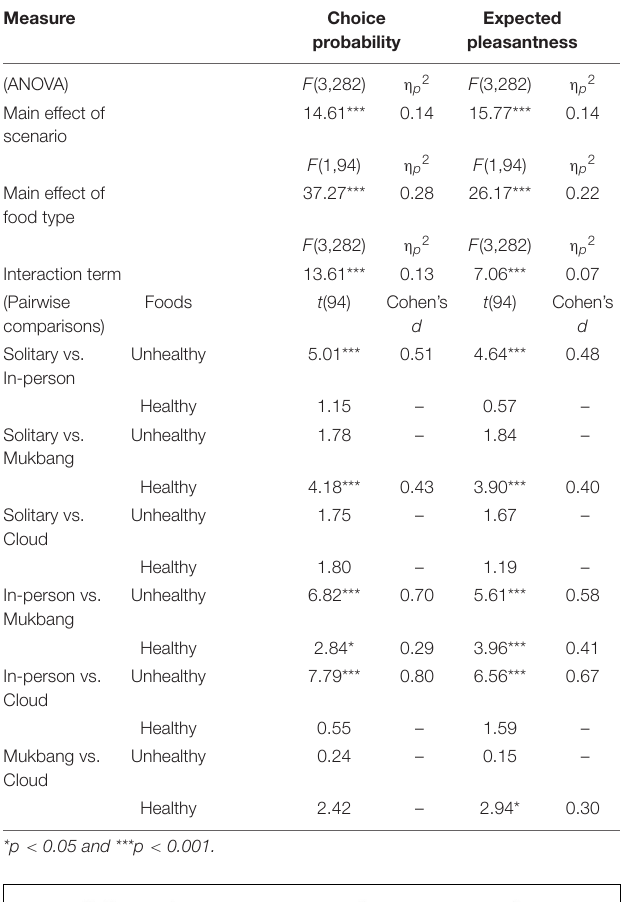
TABLE 3 | The results of ANOVA and pairwise comparisons performed on the data of food ratings.